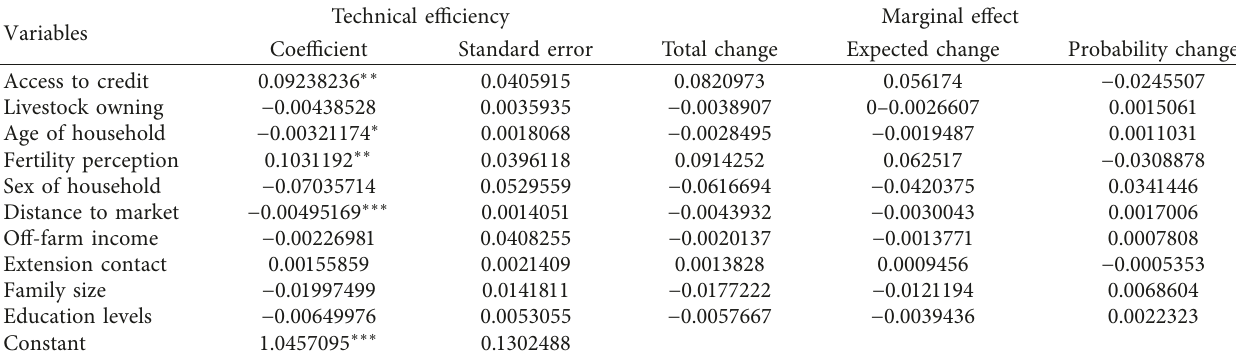
Table 5: Determinants of technical efficiency from Tobit model